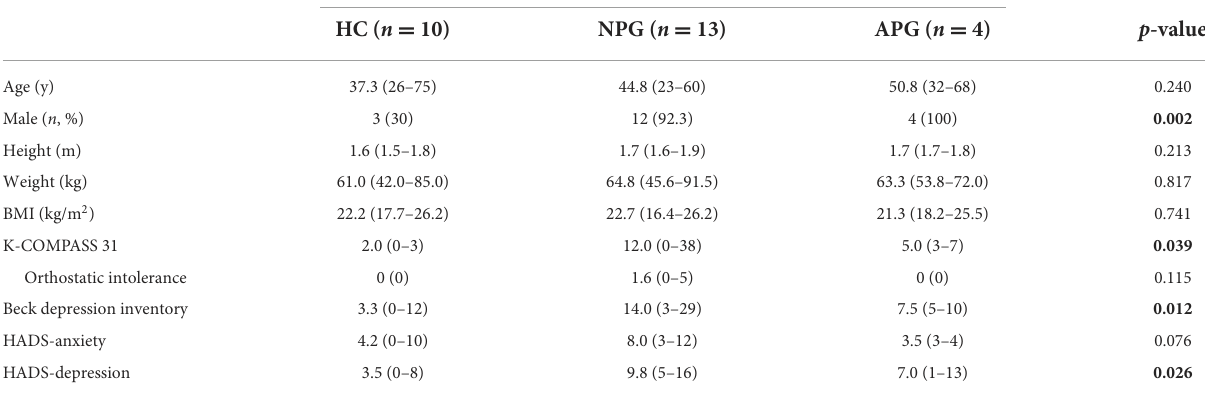
TABLE 1 Demographic and clinical characteristics of the study population.